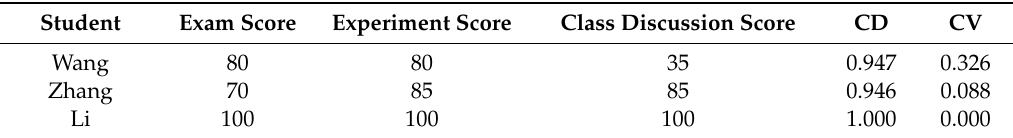
Table 1. The scores of the three students and calculated results of the CD and coe ffi cients of variation